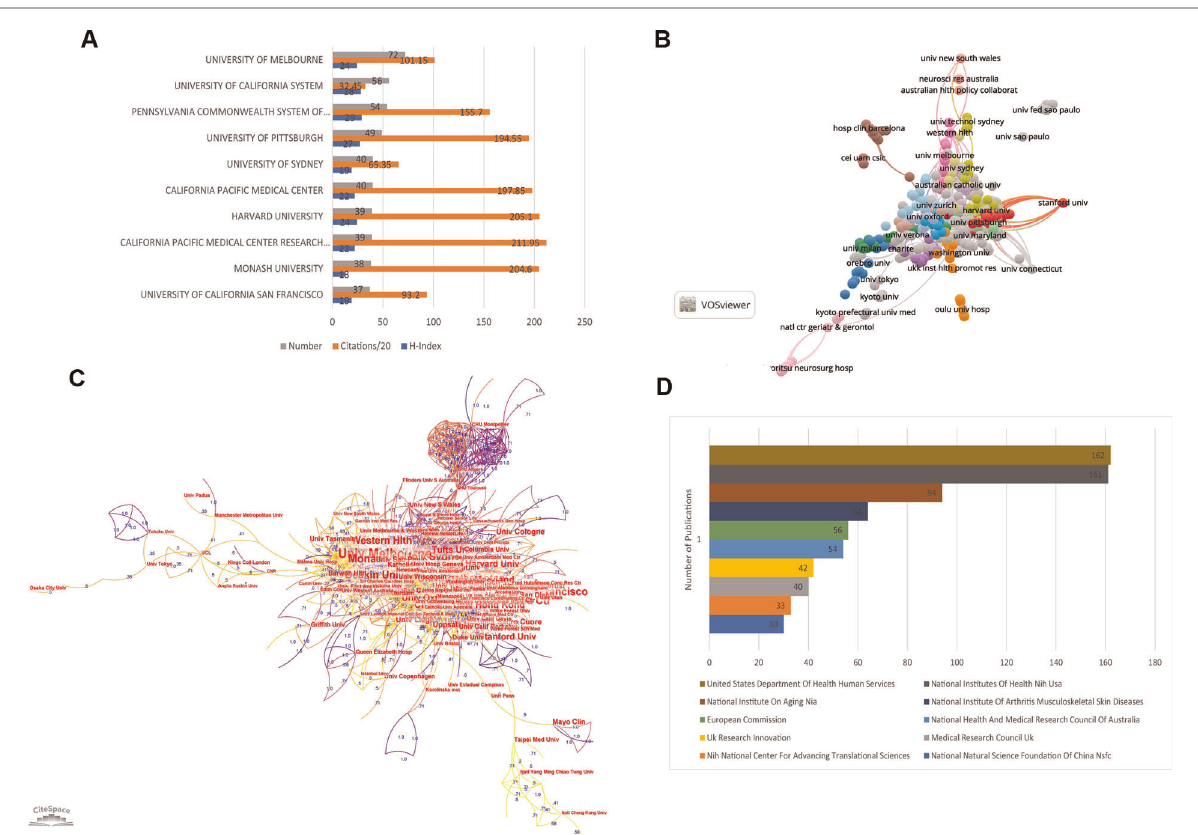
FIGURE 4 Analysis of institutions and funding organizations of publications. ( A ) The general information of top 10 productive institutions that published studies about sarcopenia and hip fractures in older patients; ( B ) Network visualization map of collaboration between institutions (generated by VOSviewer). The nodes present the institutions, and the color of the lines between two nodes presents the collaboration relationship between institutions; ( C ) network visualization map of collaboration between institutions (generated by Citespace); ( D ) the top 10 most active funding organizations for studies about sarcopenia and hip fractures in